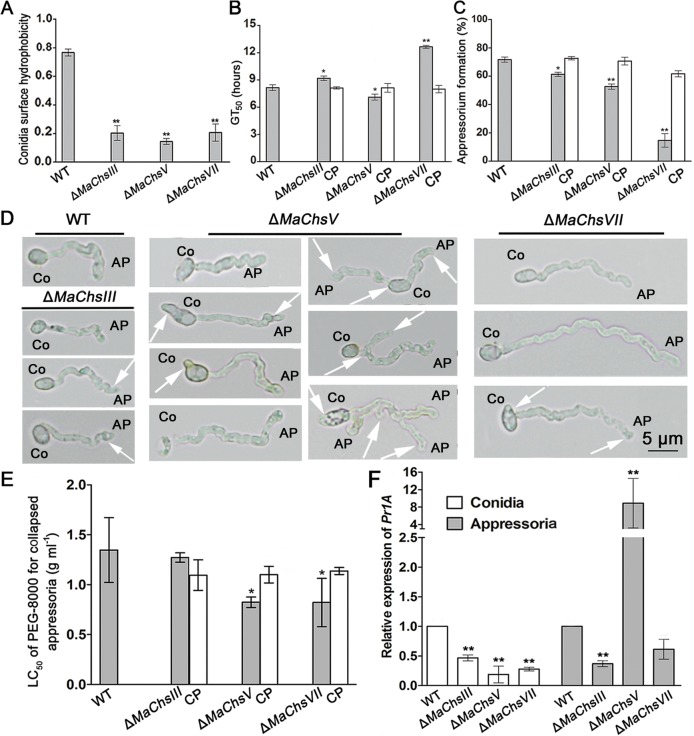
Conidial germination and appressorium formation on locust hind wings.(A) The hydrophobicity of conidia from wild type, ΔMaChsIII, ΔMaChsV, ΔMaChsVII mutants. (B) Germination time values for 50% germination (GT50) of wild type, ΔMaChsIII, ΔMaChsV, ΔMaChsVII mutants on locust hind wings. (C) Rates of appressorium formation in germinated conidia. (D) Appressorium morphology of wild type, ΔMaChsIII, ΔMaChsV, ΔMaChsVII mutants. White arrows represent the various defects of conidia and appressoria. (E) LC50 of PEG-8000 of collapsed appressoria. (F) The relative expression levels of Pr1A gene (GenBank accession number: AAV97788) in mature conidia and appressoria (after induced 30 h on locust wings) of wild type, ΔMaChsIII, ΔMaChsV, ΔMaChsVII mutants. A single asterisk above bars denotes significant difference, P < 0.05; double asterisks above bars denote significant difference, P < 0.01. Error bars indicate standard errors of three trials.